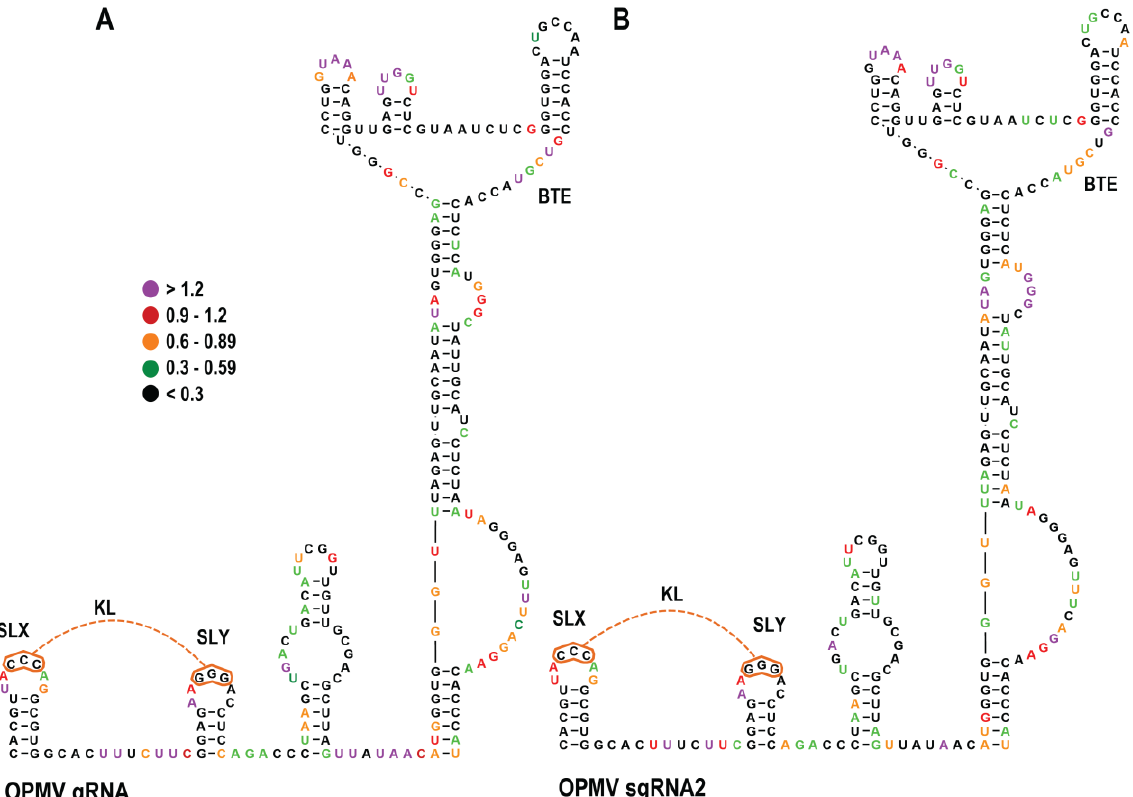
Figure 4. SHAPE RNA structure probing of the OPMV CAS region in full-length gRNA and sgRNA2 transcripts. ( A ). SHAPE was conducted using fluorescently labeled primers, which differed experimentally from previous SHAPE probing of the OPMV gRNA 3ʹUTR [20] but generated similar results. Individual residue “dots” are colored according to NMIA reactivity, from purple (most reactive) to black (least reactive). ( B ). SHAPE data for the CAS region in full-length OPMV sgRNA2 transcripts.